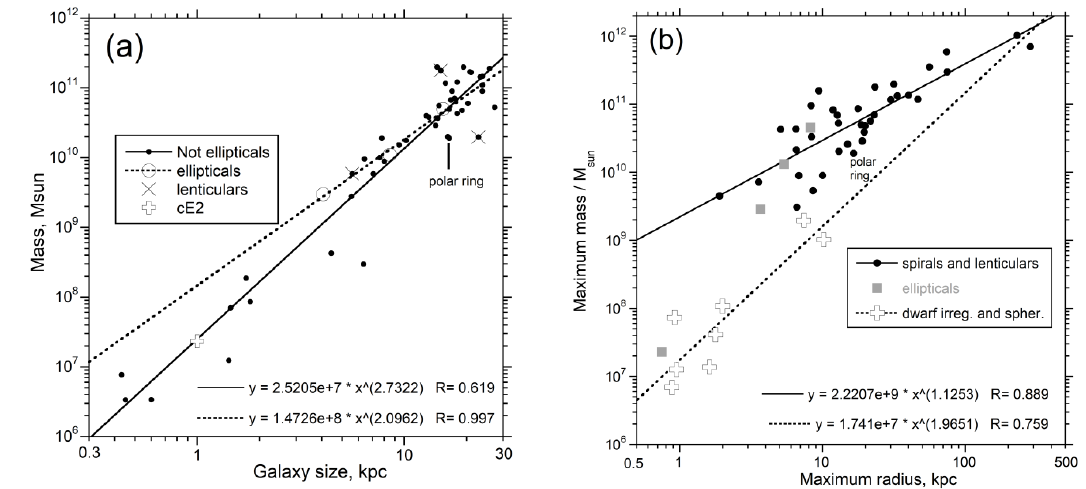
Figure 11. Galaxy mass – size relationships. ( a ) Dependence of galaxy mass on the position of the visible edge. ( b ) Dependence of the largest mass calculated for each galaxy on the radius where the largest mass was calculated. In most cases, this radius is the outer cutoff of available data, but some exceptions exist. Fits are to certain types, as listed in the inset.